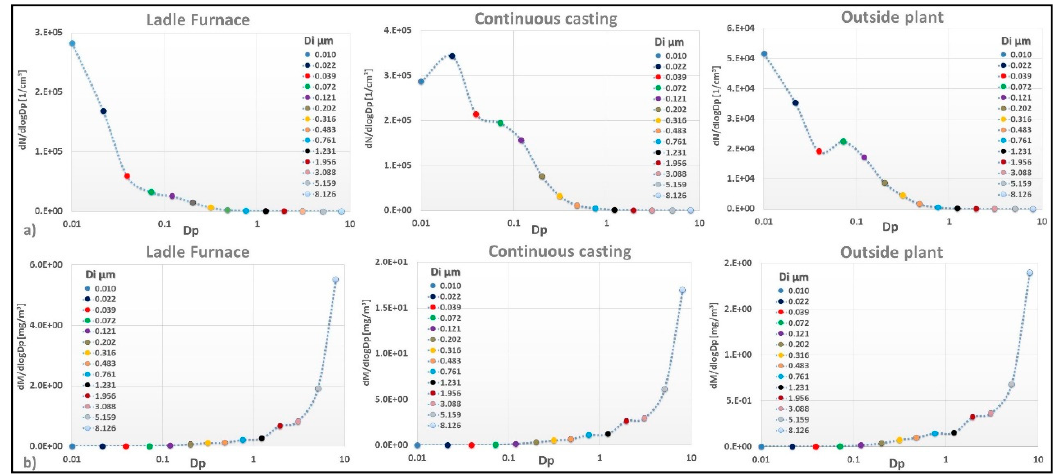
Figure 6. Particle number ( a ) and ( b ) mass distribution measured with the ELPI for locations (ladle furnace, continuous casting, and outside the plant).